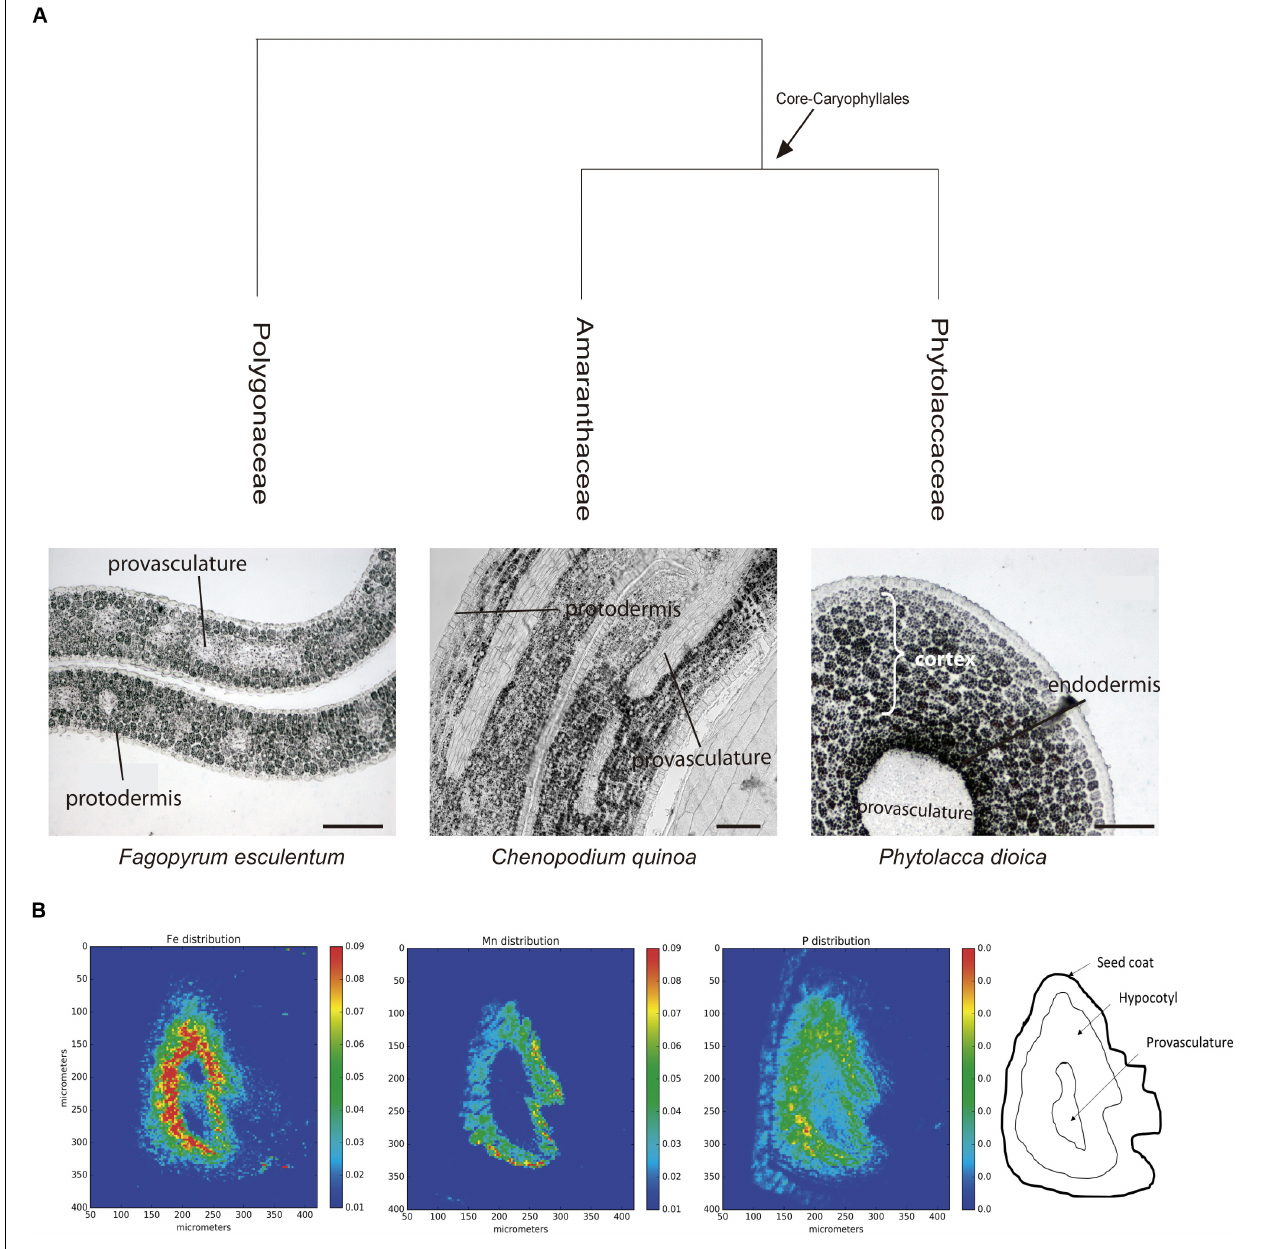
FIGURE 3 | (A) Iron distribution in Caryophyllales mature embryos. Perls/DAB stained embryo sections from polygonaceae, amaranthaceae, and phytolaccaceae families ( Fagopyrum esculentum , Chenopodium quinoa , and Phytolacca dioica , respectively). Bars in panels correspond to 50 µ m. (B) Iron detection in hypocotyl Quinoa dry seed section using synchrotron-based micro X-ray fluorescence (S µ XRF). P, Mn, and Fe distribution are